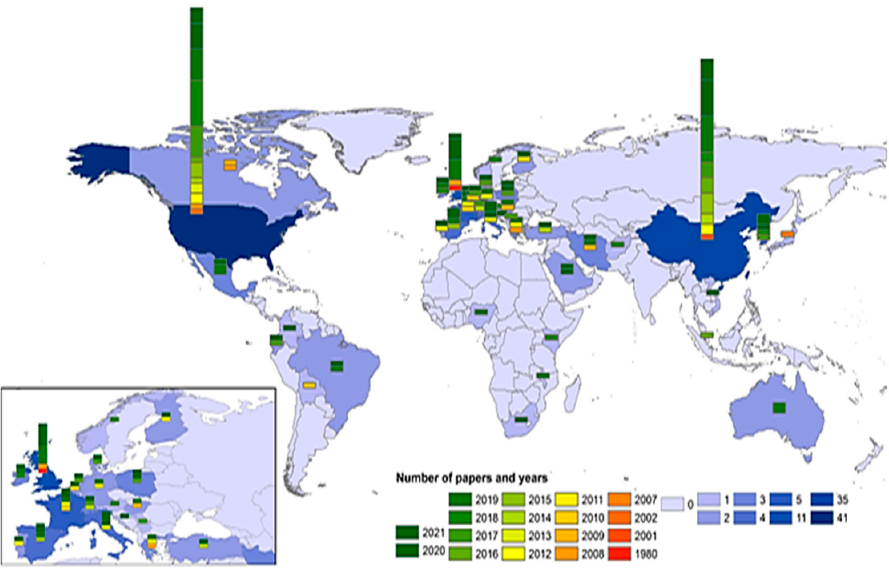
Figure 3. Spatial and temporal distribution of papers on ML related to urban applications by coun ‐ try and year